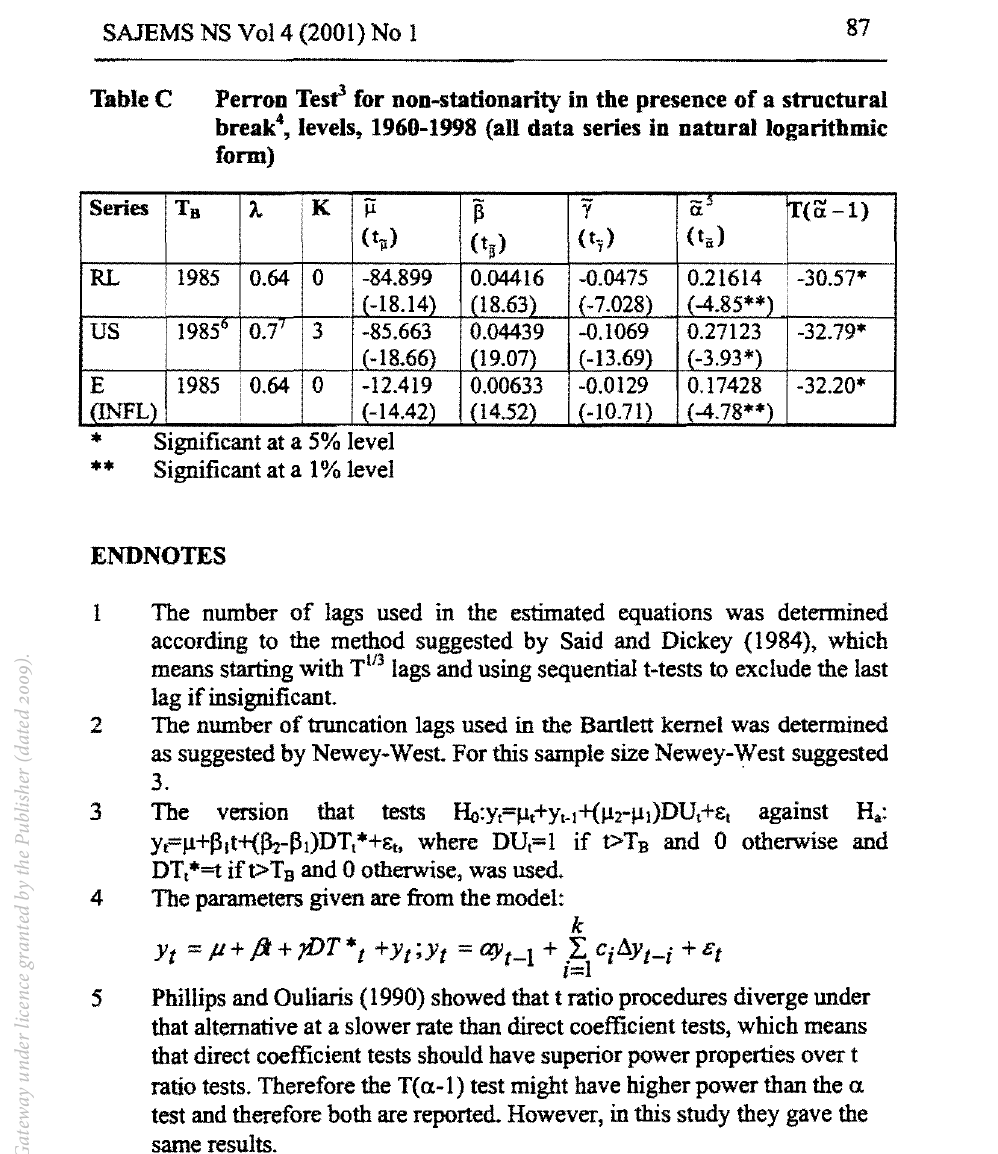
Perron Tesf for non-stationarity in the presence of a structural break 4 , levels, 1960-1998 (all data series in